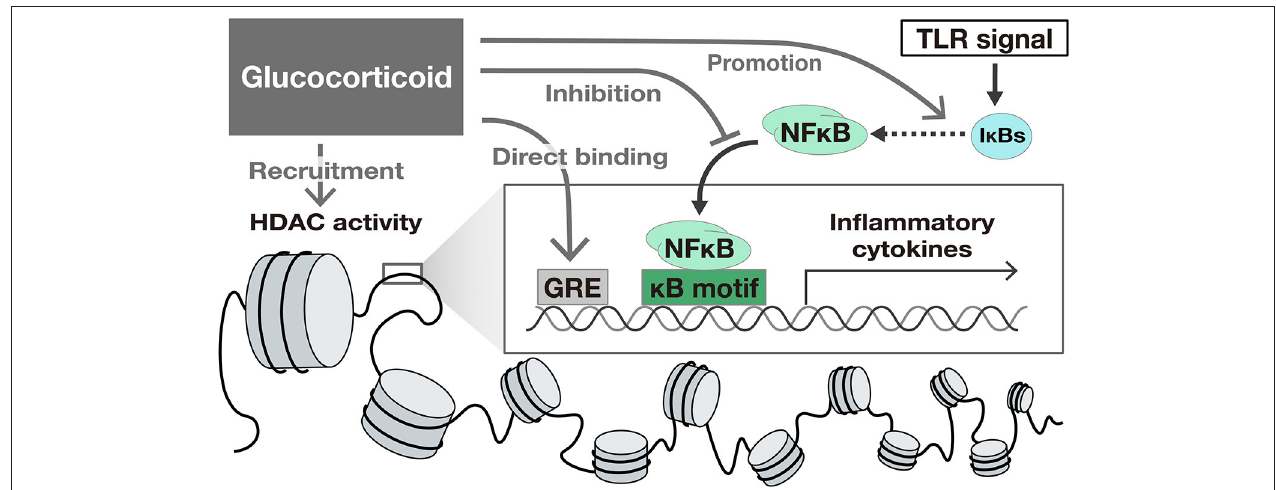
FIGURE 2 | The suppressive effect of Glucocorticoids on TLR-induced gene activation. Glucocorticoids suppress gene transcription by several mechanisms including (1) binding to specific recognition sequences, namely glucocorticoid response elements (GREs) on the DNA, (2) promotion of anti-inflammatory proteins such as I κ Bs, (3) interference with the translocation of NF κ B, and (4) epigenetic modification by recruitment of Histone deacetylases (HDAC) to the transcriptional region.